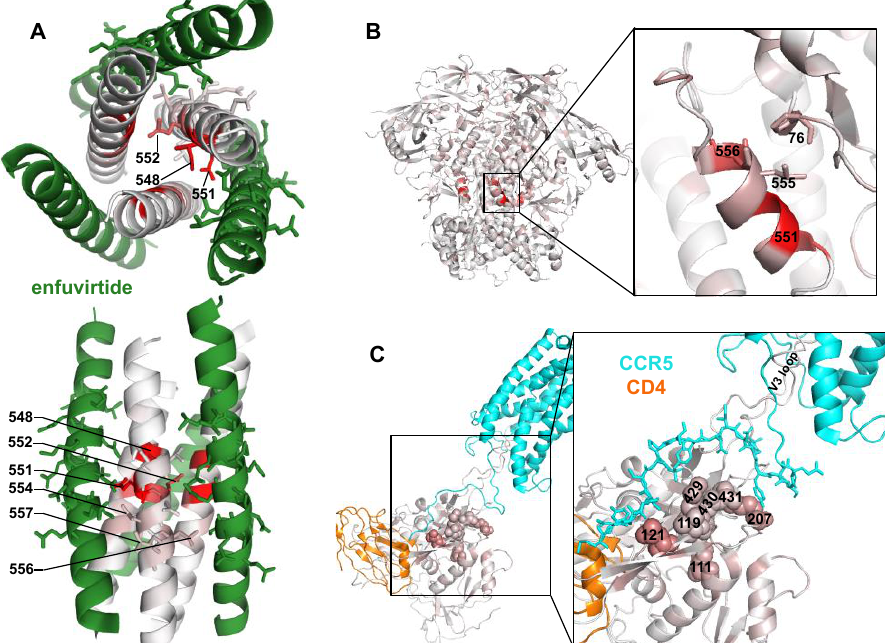
Figure 2. Locations of potential resistance mutations in different Env conformations. ( A ) A structural model of enfuvirtide (green) binding to the N39 NHR coiled-coil trimer (colored white to red according to the positive site differential selection at each site). Sites 547 – 557 of the NHR, and sites 136-150 of enfuvirtide (using Env numbering) are shown with sticks to highlight side chain positions within the binding interface. PDB:5ZCX. ( B ) The closed, pre-fusion conformation of Env colored white to red according to the maximum mutation differential at each site. PDB:5FYK. ( C ) The CCR5- (cyan) and CD4- (orange) bound gp120 structure, colored white to red according to the maximum mutation differential at each site. The top 2% of resistance sites ( n = 13 of 670 mutagenized sites, 9 of which are in this gp120 structure) are shown with spheres. Residues 1 to 18 of CCR5 are shown with sticks to indicate bridging sheet interactions. PDB:6MEO.